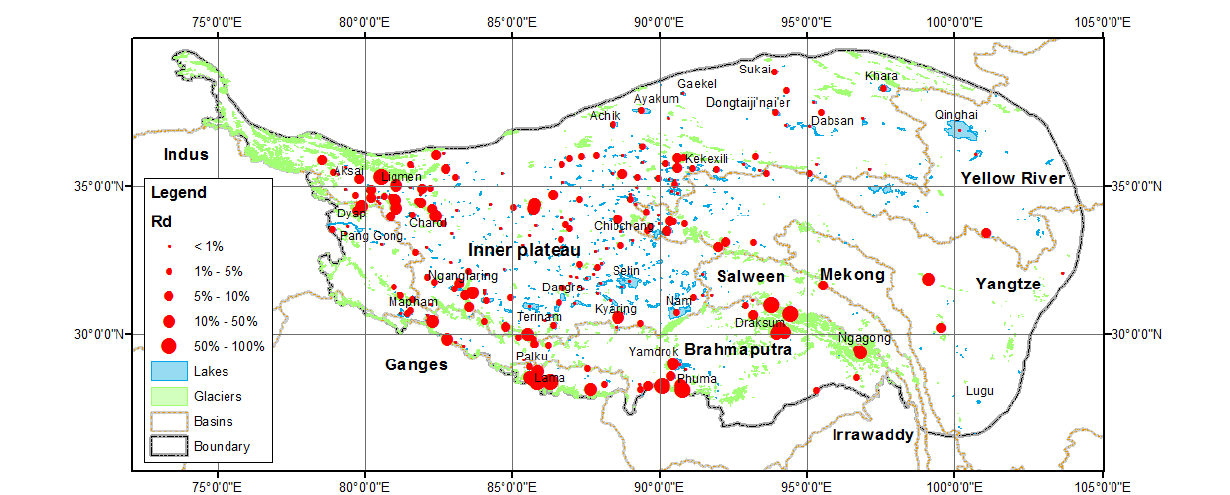
Figure 4. Dependency of the Tibetan lakes on direct glacial runoff determined by integrating the SRTM and glaciers inventory (Phan Hien et al.,